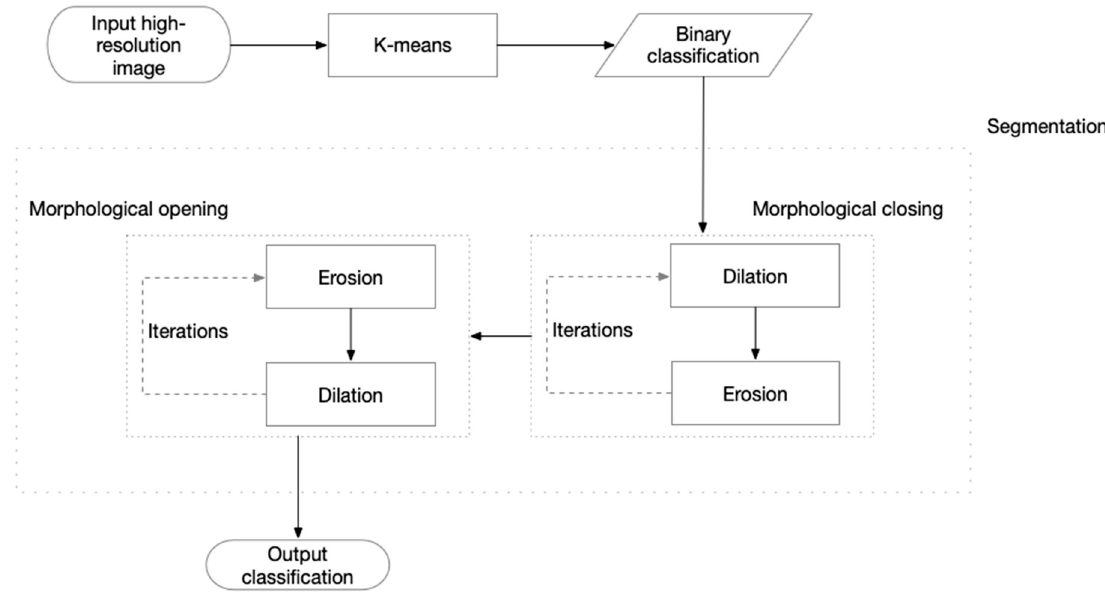
Figure 9. The workflow of the proposed k-means segmentation (KMSEG) method. KMSEG makes use of unsupervised clustering and morphological image processing methods to classify the image.